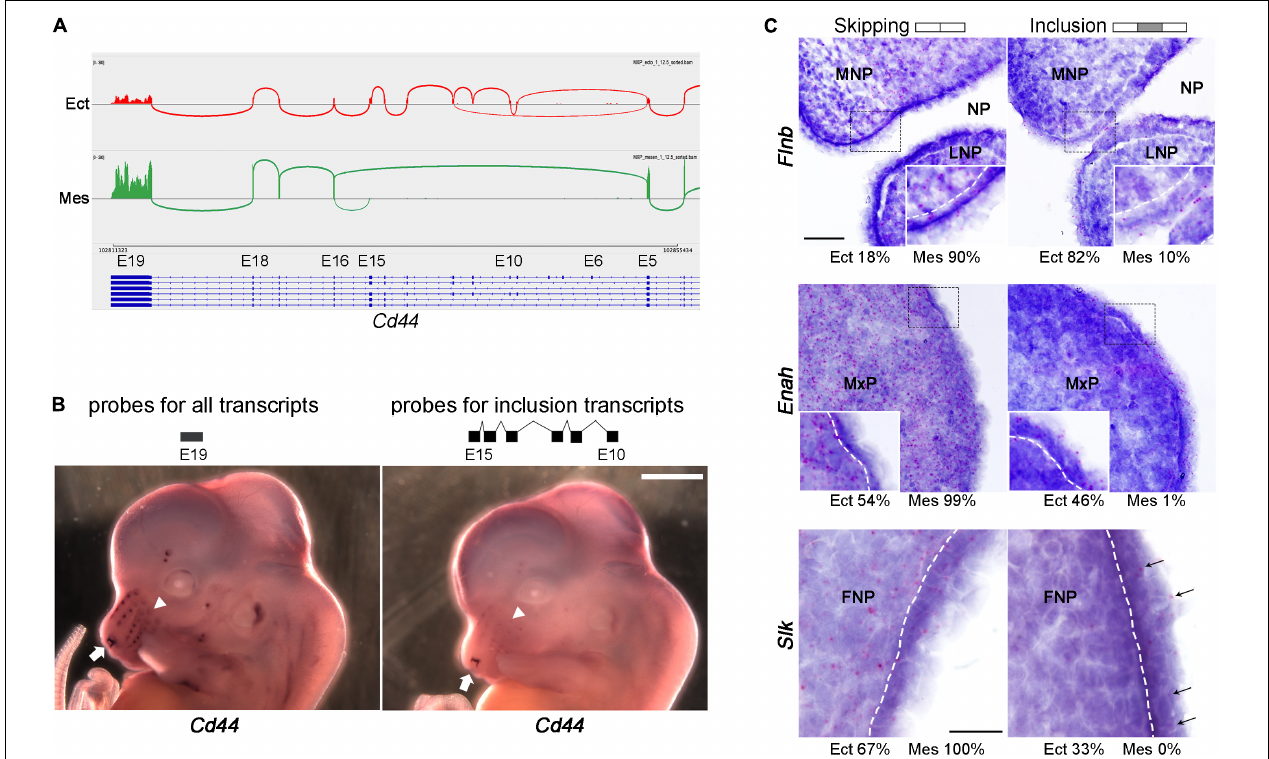
FIGURE 4 | In situ hybridization validation of SE events across tissue layers. (A) Sashimi plot showing skipping of multiple exons (exons 6–15) of Cd44 in mesenchyme. Sashimi plot was generated by using IGV browser with RNA-seq.bam files of E12.5 MxP ectoderm (Ect) sample 1 (top track, red) and E12.5 MxP mesenchyme (Mes) sample 1 (bottom track, green). The vertical piles are RNA-seq reads of exons, while the arcs connecting exons show how the exons are spliced. The isoform models are shown under the tracks with blue rectangles as exons, lines as introns, and arrowheads indicating the direction of transcripts (right to left). Exon (E) numbers of Cd44 transcript variant 1 (NM_009851.2) are marked on top of the transcripts. Note that only the splicing junctions with five or more reads are shown here. (B) Whole mount in situ hybridization of E12.5 embryos for an exon 19 probe detecting all Cd44 transcripts (left panel) or an exons 10–15 probe specific for ectodermal transcripts (right panel). The arrows point to the nasal cavity and the arrowheads point to vibrissae. Scale bar: 1 mm. (C) In situ hybridization on E11.5 frontal sections of FNP, MxP, and FNP using Basescope for SE events in Flnb, Enah, and Slk, respectively. Gene names are shown on the left and probes (skipping or inclusion) on top. The rMATS estimated average percentage of skipping and inclusion for Ect and Mes tissues (FNP for Flnb , MxP for Enah , and FNP for Slk ) are shown under the corresponding panels. Red punctuate dots are signals for the Basescope probes. The sections are counterstained with hematoxylin. For all three genes the isoforms with the skipped exon are expressed in both ectoderm and mesenchyme, while the isoforms which include the alternative exon are mainly expressed in the ectoderm. Insets in Flnb and Enah panels show enlarged images of the areas in the dashed lined rectangles. White dashed lines indicate the boundary between ectoderm and mesenchyme. In the Slk panels, arrows indicate Basescope signals for the probe detecting the alternative exon. Scale bar is 50 µ m for the Flnb and Enah panels, and scale bar for Slk is 20 µ m. FNP, frontonasal process; LNP, lateral nasal process; MNP, medial nasal process; MxP, maxillary process; NP, nasal